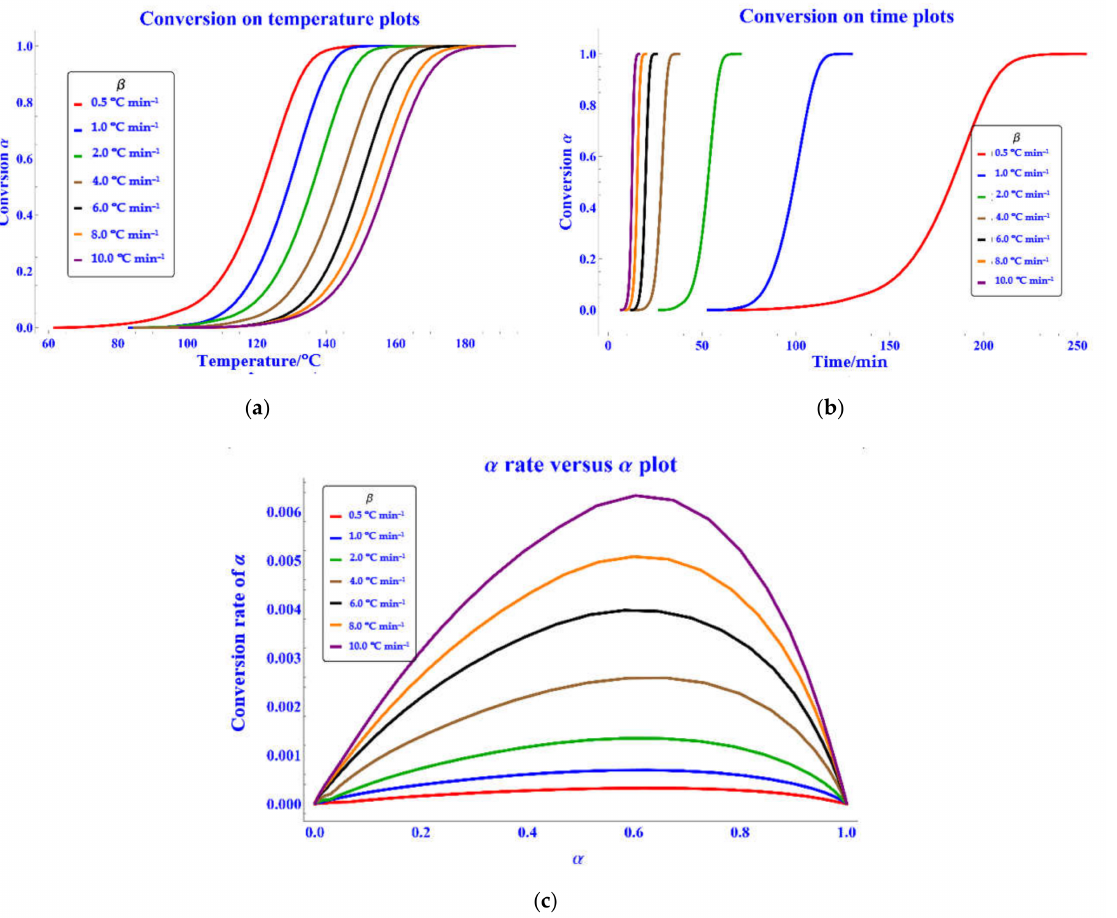
Figure 9. The degree of conversion-related plots ( a ) α versus T plots; ( b ) α versus t plots; ( c ) (d α /d t ) versus α